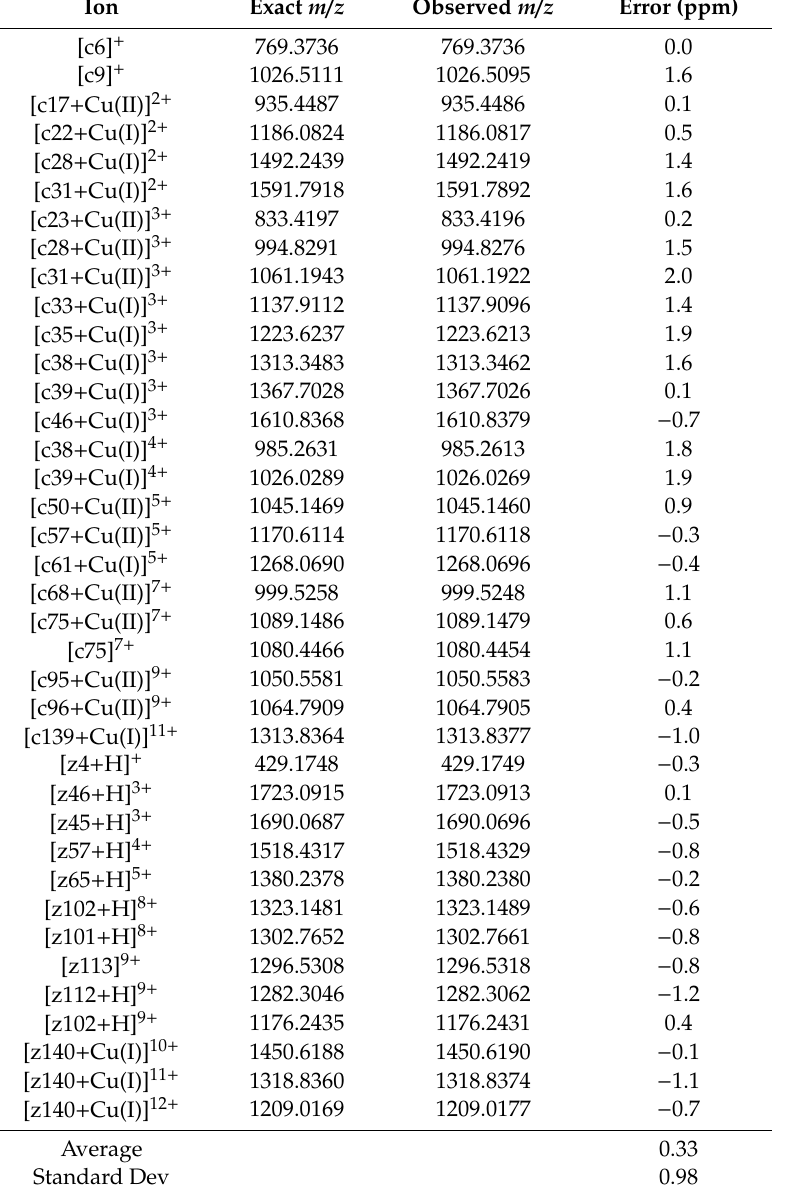
Table A4. Electron-capture dissociation of [ α -syn +